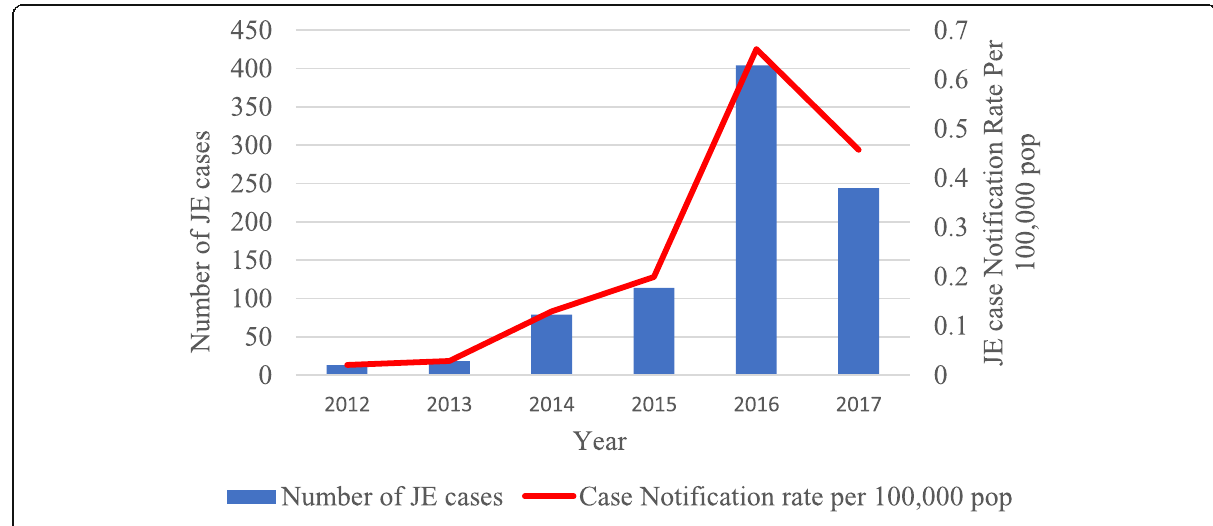
Fig. 1 Annual hospital-reported JE cases and case notification rates per 100,000 population in Myanmar: 2012 to 2017